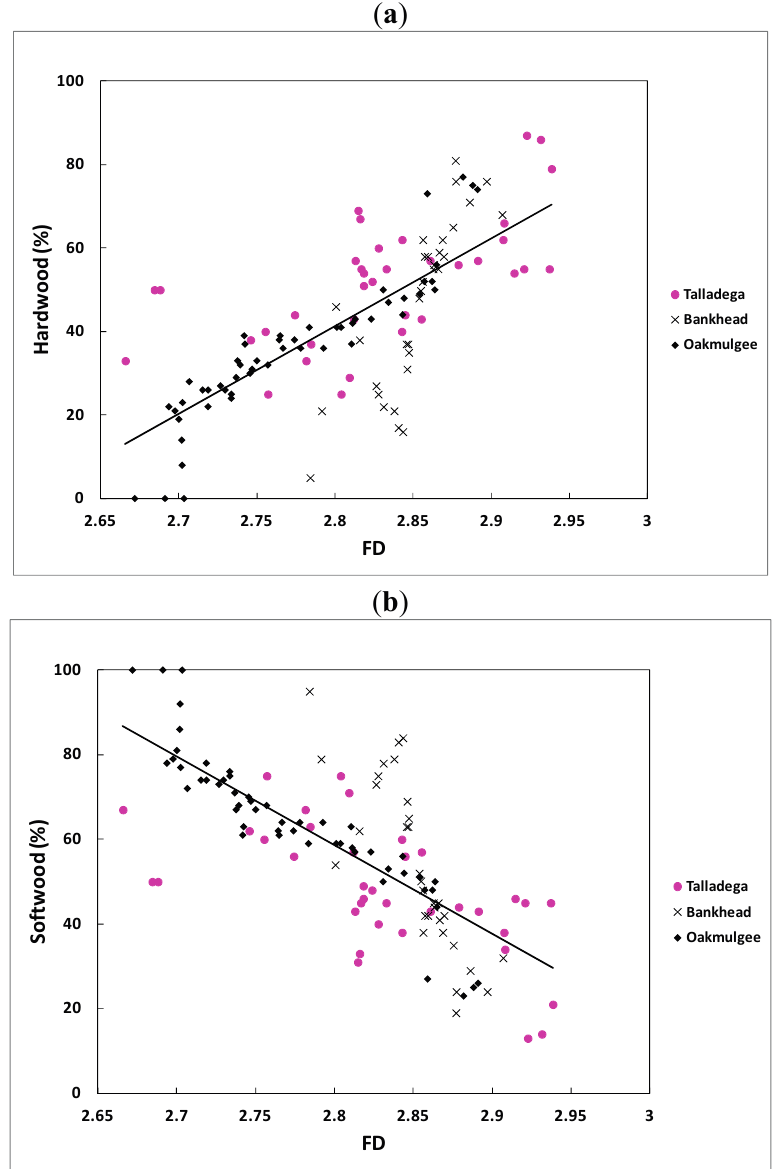
Figure 6. Linear regression prediction models using Fractal Dimension